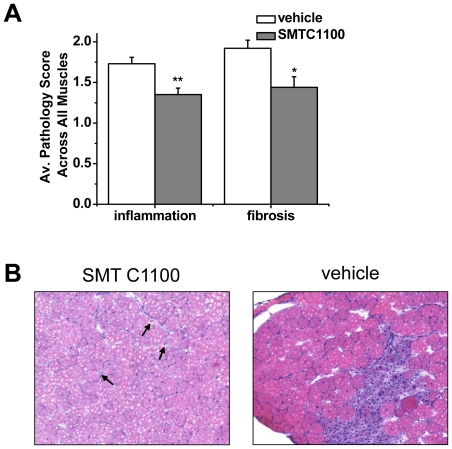
Reduction in secondary pathological features.(A) Data demonstrates the reduction in overall skeletal muscle
inflammation and fibrosis from mdx treated with SMT
C1100 compared to vehicle only. SMT C1100 (50 mg/kg) or vehicle was
delivered daily by oral gavage to groups of six mdx
mice aged around 17 d for a total of 28 days. The TA, EDL, soleus, and
diaphragm were removed and five sections from each muscle were stained
and analysed blind by a board-certified veterinary pathologist for
evidence of inflammation and fibrosis using a standard pathology scoring
method described in the methods
section. Scoring (0–3) was made for each section from each muscle
then averaged for all muscles to give an overall assessment of
improvement in the pathological effects of dystrophin deficiency; (B)
Qualitative assessment of EDL muscle from SMT C1100-dosed
mdx scored as 1 = mild -
occasional mononuclear inflammatory cells in the inter-bundle connective
tissue with focal aggregations of mononuclear inflammatory cells. The
arrows mark foci of inflammation. Qualitative assessment of EDL dosed
with vehicle and scored as 2 = moderate - multiple
foci of mononuclear inflammatory cell infiltration in the inter-bundle
connective tissue; occasional mononuclear inflammatory cells between
individual muscle fibres.